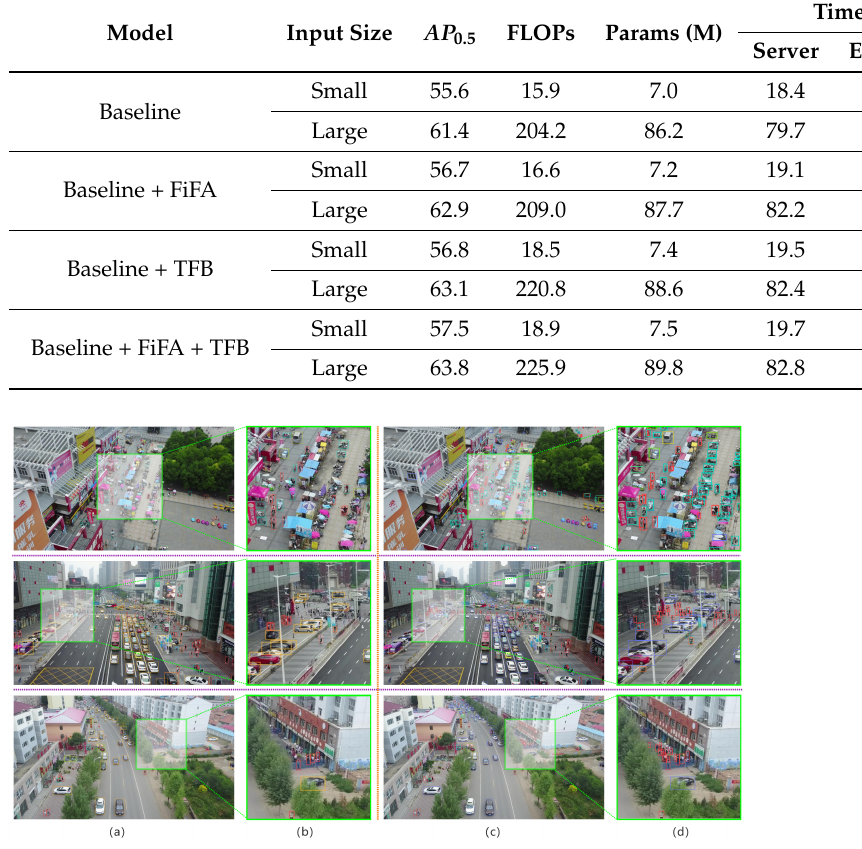
Figure 10. Visualization of the detection performance of our method. ( a ) Baseline detection results. ( b ) Zoomed-in baseline detection results on the sub-area. ( c ) Our detection results. ( d ) Our detection results on the corresponding sub-area.